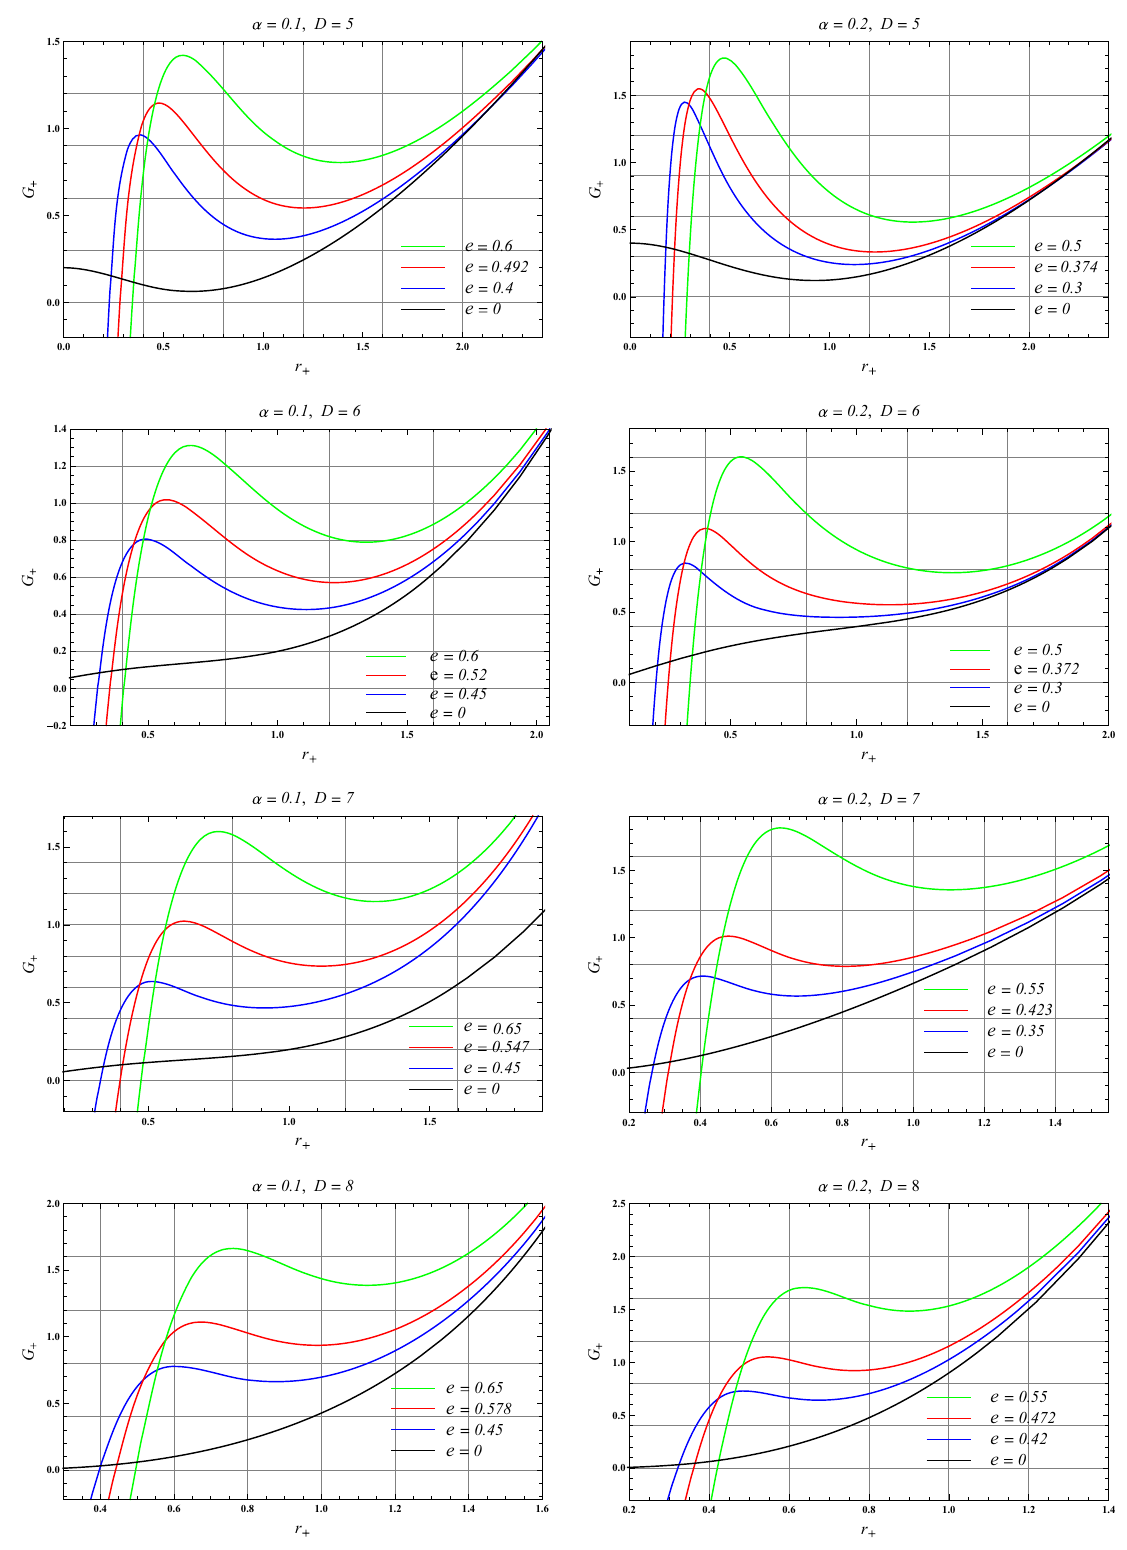
Fig. 5 Gibb’s free energy G + vs horizon radius r + in various dimensions D = 5, 6, 7, and 8 (top to bottom) for different values of charge ( e ) with Gauss–Bonnet coupling parameter α = 0 . 1 and 0.2 (left to right) with μ (cid:9) =